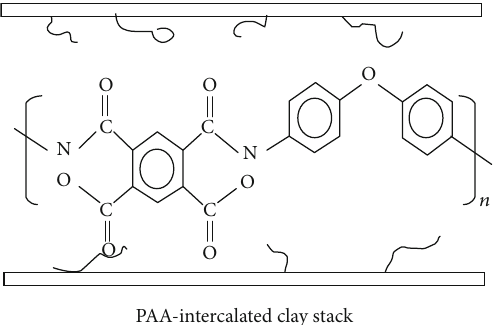
Figure 16: Representation of intercalation of the montmorillonite clay stack. Courtesy of Wang et al.